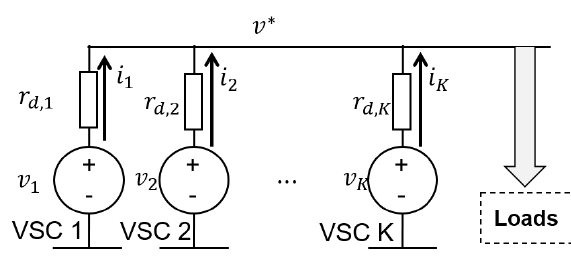
Figure 5. Single bus DC MG system with K VSC units in the steady state.